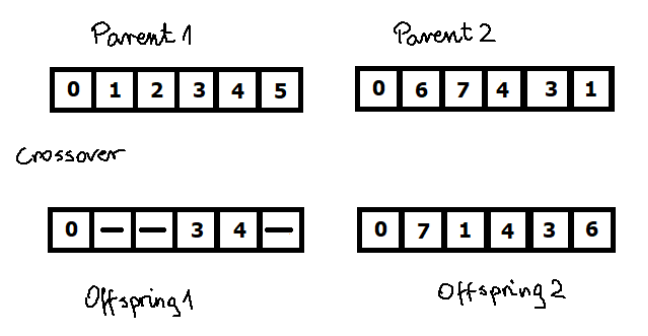
Figure 4. Order crossover operation for the VRP integer solution.